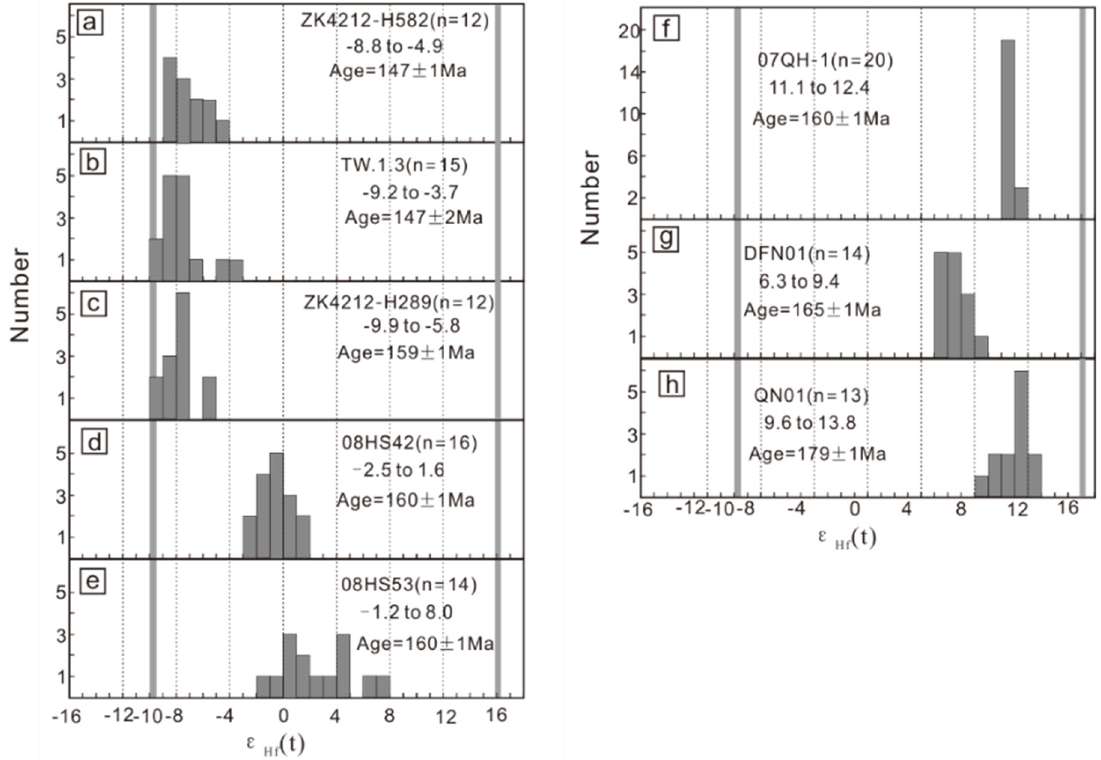
Figure 12. Frequency distributions of ε Hf (t) values of zircons from ( a ) Zhuxi two-mica granite, ( b ) Zhuxi biotite granite, ( c ) Zhuxi granodiorite, ( d ) Lisong monzogranite, ( e ) Lisong mafic microgranular enclaves, ( f ) Qinghu monzonite, ( g ) Dafengnao syenite, and ( h ) Huangbu syenite. The data for Lisong monzogranite, mafic microgranular enclaves, and Qinghu monzonite are from [67]; data for Dafengnao syenite and Huangbu syenite are from [122].